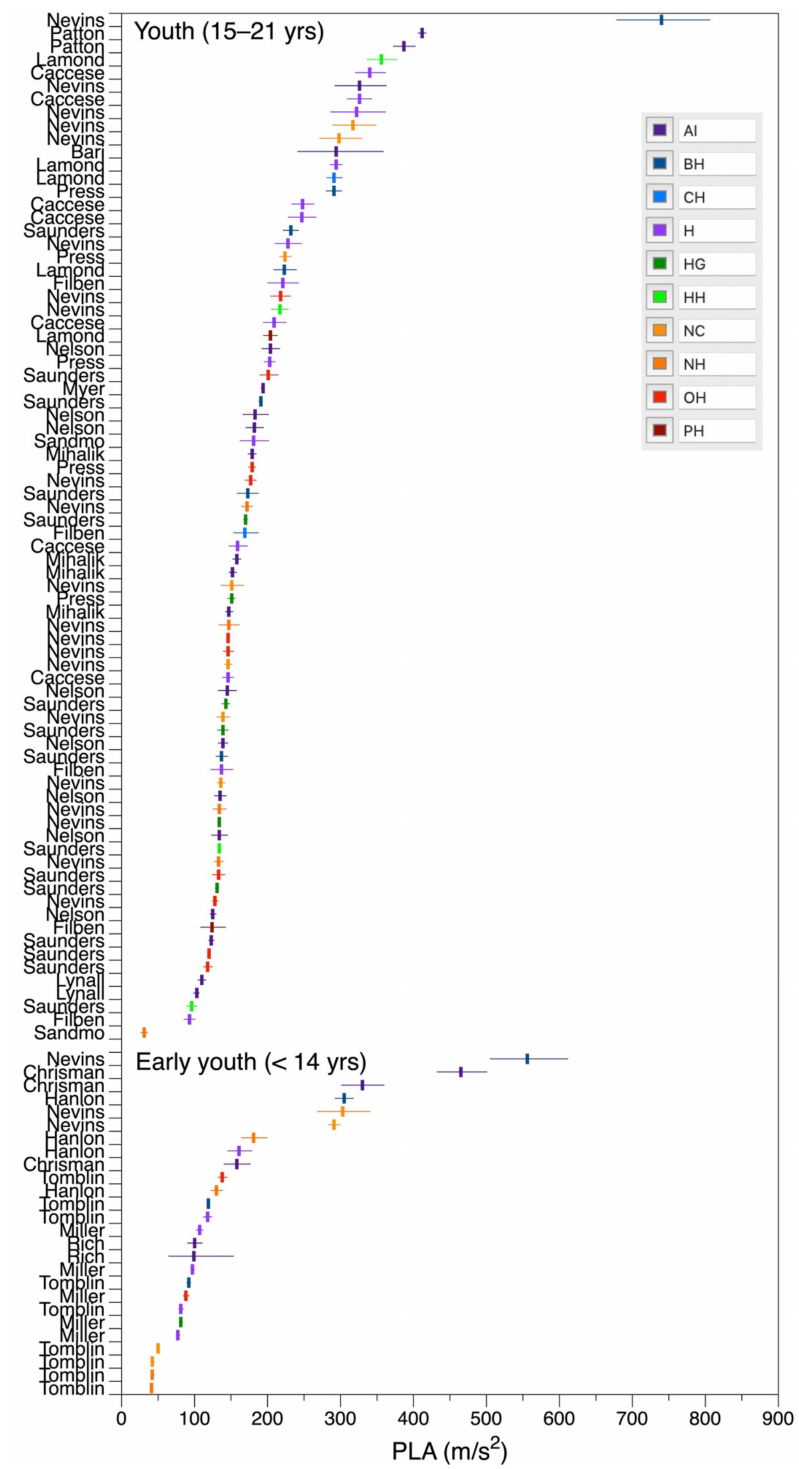
Figure 7. Forest plot of PLA for each observational study by activity or playing position, subdivided by early youth and